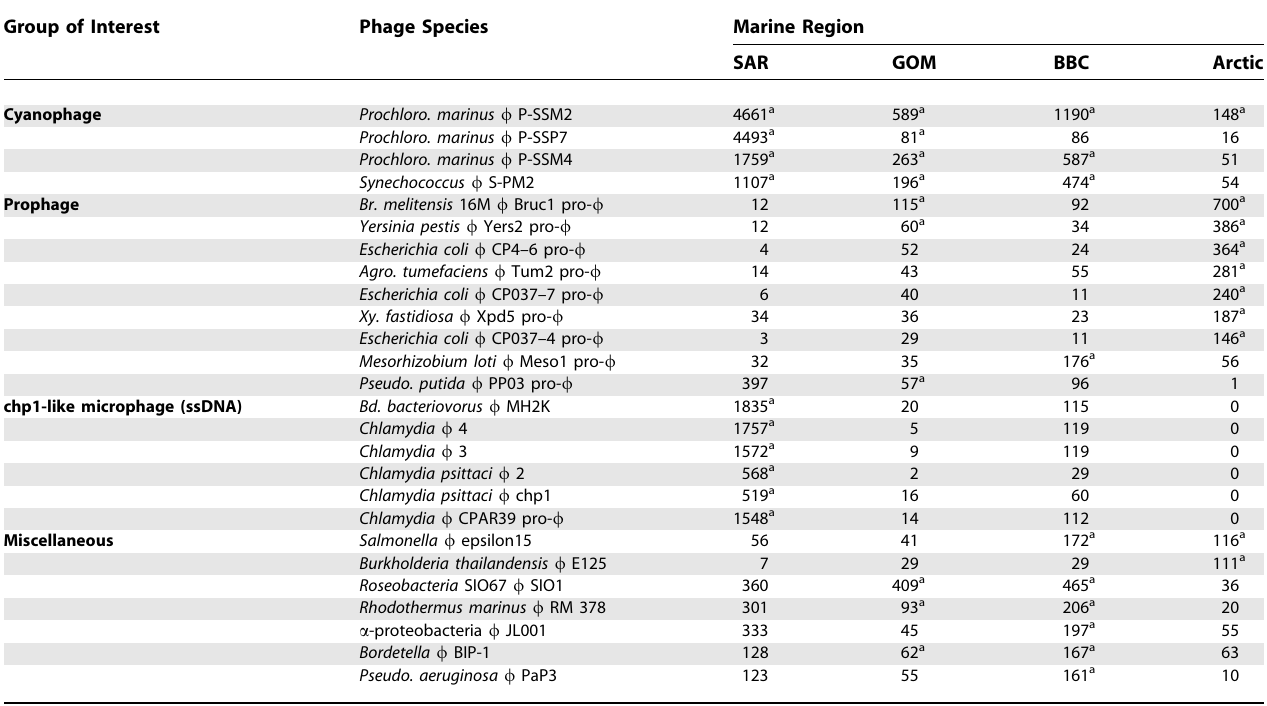
Table 1. Number of Similarities to Phage Genomes and Groups of Interest in the Four Metagenomes Group of Interest Phage